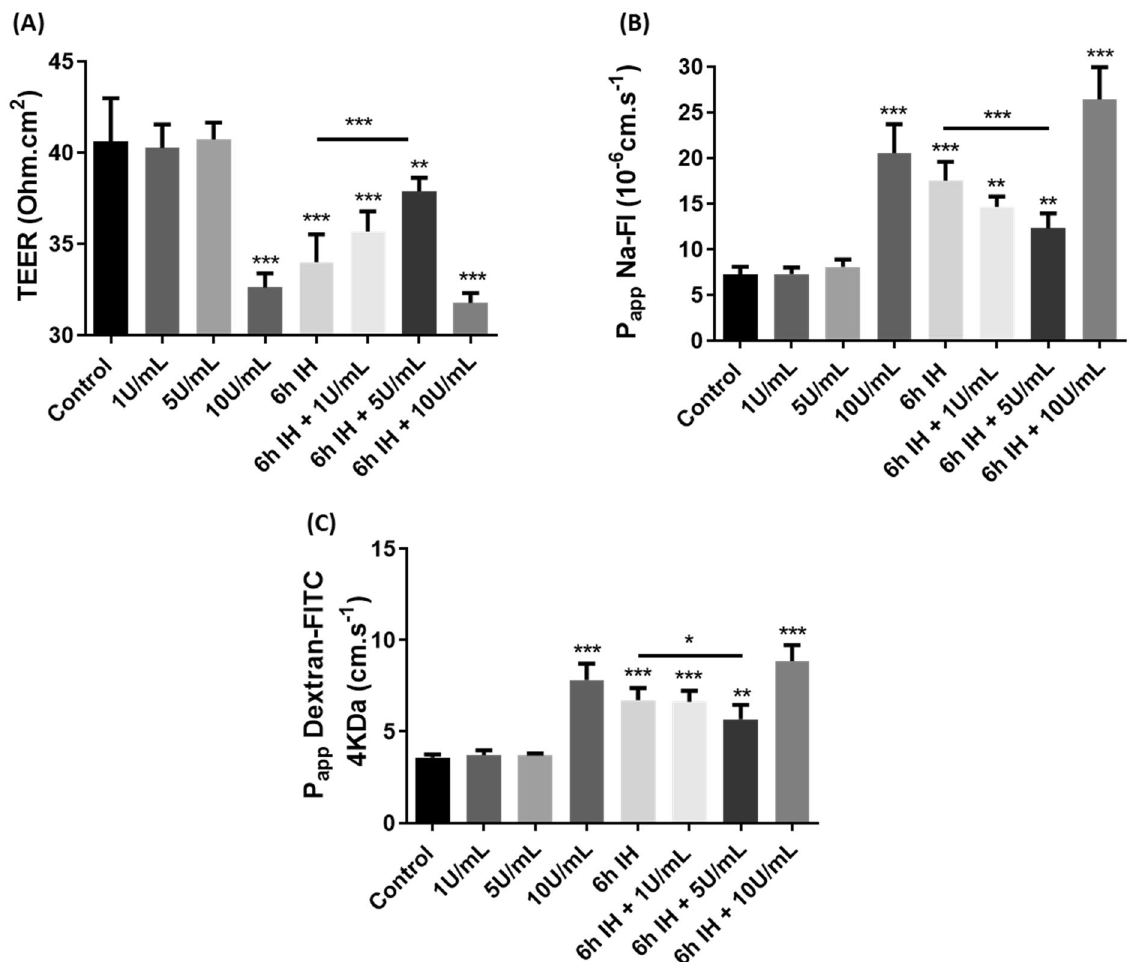
Figure 1. Transendothelial electrical resistance (TEER) ( a ) and apparent permeability (P app ) for Na–Fl ( b ) or FITC-dextran ( c ) in our different conditions. For treatment with thrombin, cells were exposed to thrombin at 1 or 5 or 10 U/mL for 1 h. Then cells were also exposed to 6 h of IH alone or associated with thrombin at 1 or 5 or 10 U/mL during the last hour. Results are represented as mean value ± SD ( n = 9, N = 3), ** p ≤ 0.01, *** p ≤ 0.001 compared to control